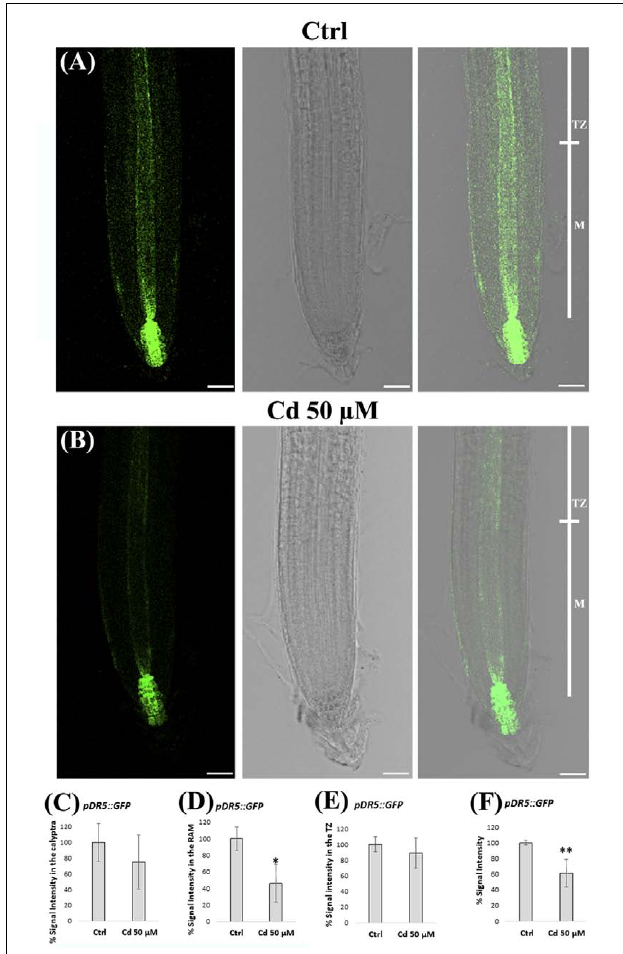
FIGURE 6 | (A,B) Images of primary root apex in seedlings of A. thaliana pDR5::GFP transgenic line germinated (A) on growth medium as control (Ctrl) and on medium added with (B) 50 µ M Cd for 8 days after germination. From left to right: confocal laser image; transmission image; merged image. pDR5::GFP relative signal intensities (normalized to Ctrl), in (C) the calyptra, (D) the RAM, (E) the TZ and (F) the whole root apex, of above mentioned Ctrl and Cd-treated roots. The results represent the mean value ( ± standard deviation) of three independent biological replicates. Asterisks indicate significant pairwise differences using Student’s t- test ( ∗ P < 0.05; ∗∗ P < 0.01; ∗∗∗ P < 0.001). Scale bars 46 µ m.